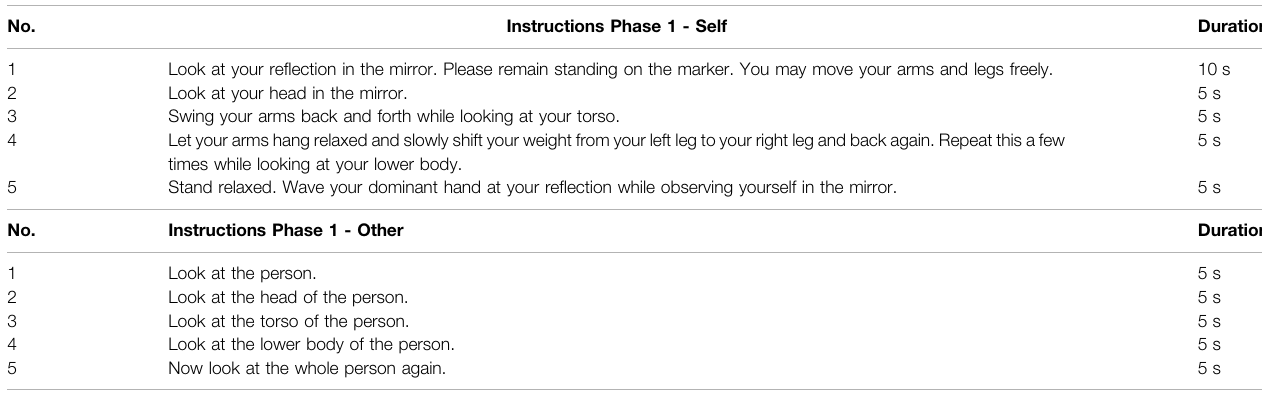
TABLE 1| Instructions that participants received in Phase 1while they had toinspect the virtual human inthe mirror or monitor. In Phase2, when participants saw both self- avatars or both virtual others at the same time, they received each instruction twice; fi rst for the left mirror, then for the right mirror, e.g., “ Look at your head in the left mirror. ”– 5 s duration – “ Look at your head in the right mirror. ” – 5 s duration. No. Instructions Phase 1 - Self